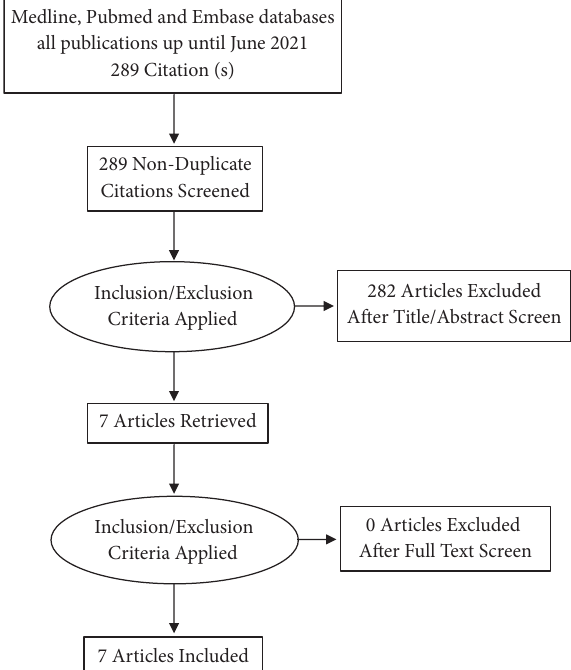
Figure 1: PRISMA flow diagram summarising the search